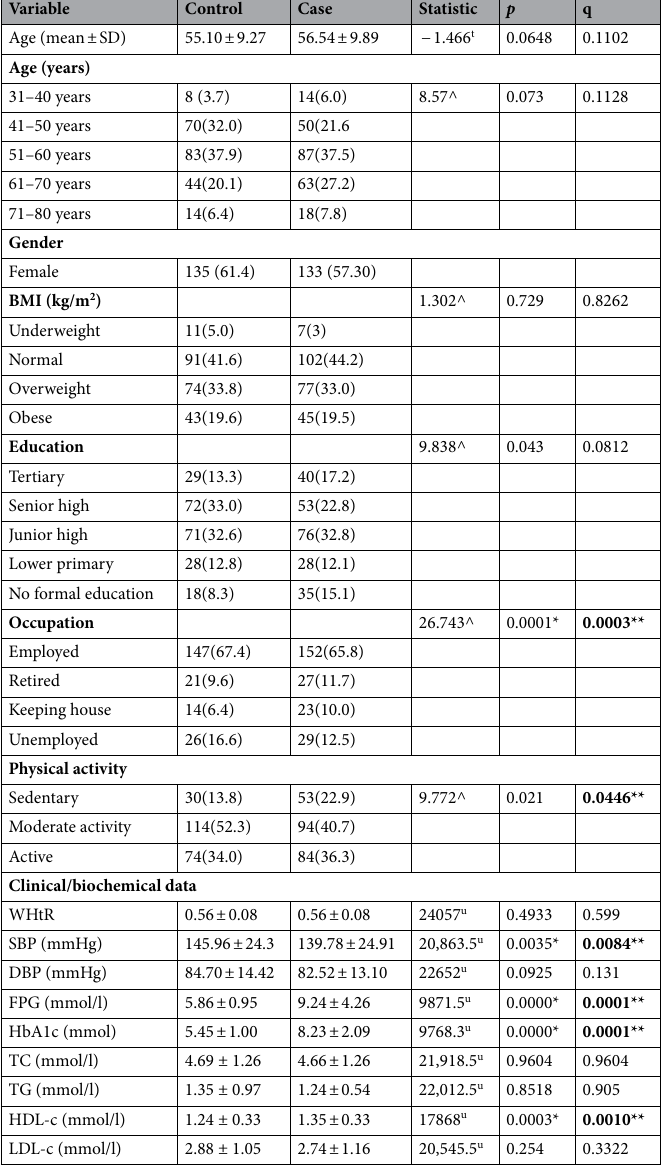
Table 1. Characteristics of participants with and without T2DM. Data presented as Mean ± SD and n (%). ^ χ 2 test of independence, t Student’s t-test, u Mann Whitney U tests. Tests of significance were two tailed (* p < 0.05); **q < 0.05F significant after correction for FDR and are